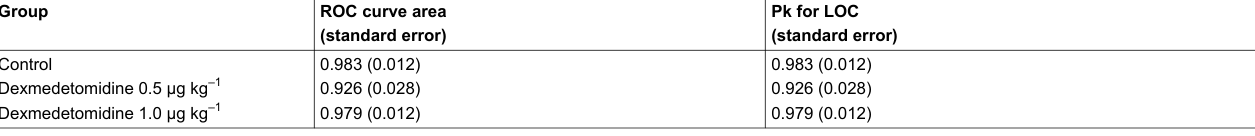
Table 4: Bispectral index and effect-site concentration of propofol at which 50% and 95% of patients lost consciousness. BIS 50 (95%CI)/BIS 95 and EC 50 (95%CI)/EC 95 for LOC in three groups.